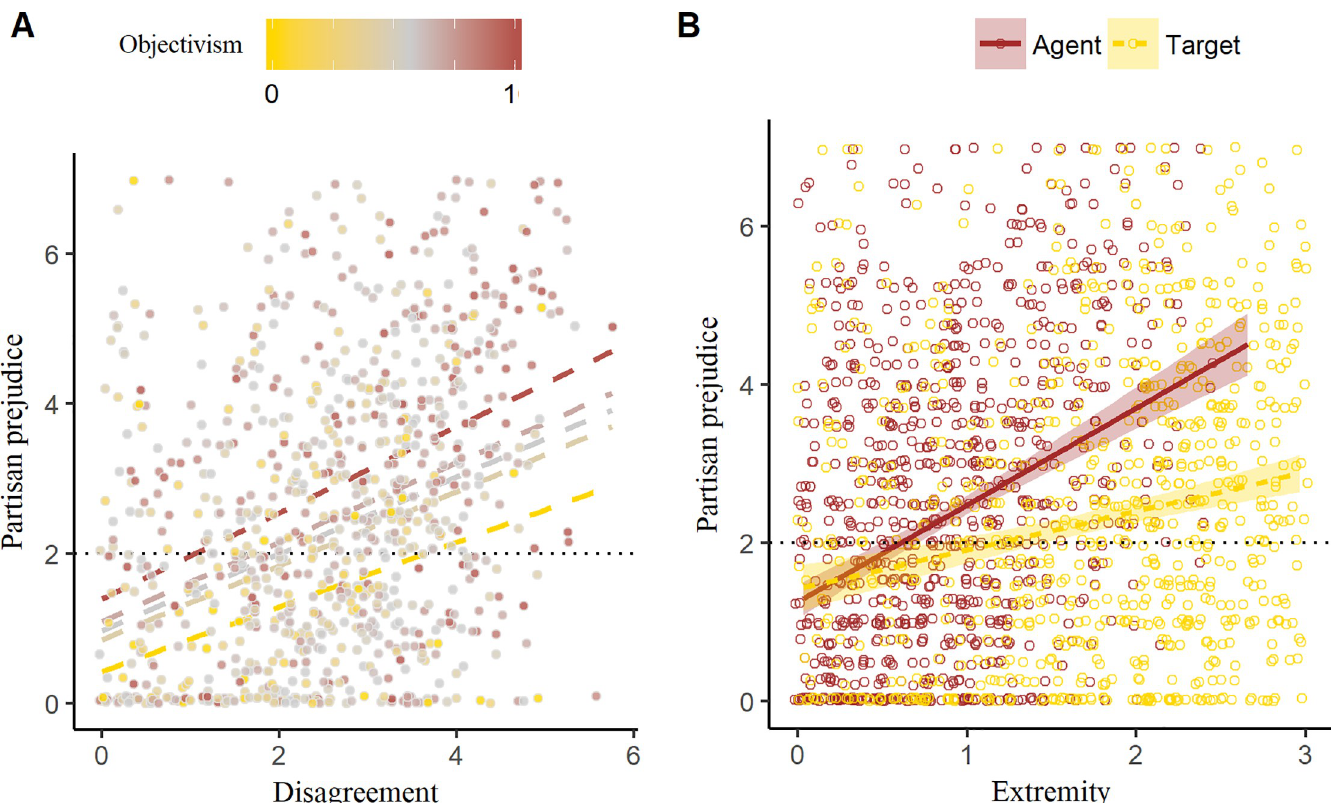
Fig 3. Observed values of partisan prejudice by (A) moral disagreement and (B) extremity. (A) Linear trend lines show the predicted prejudice at different values of meta-ethical belief: Minimum (yellow), Q 1 , Median, Q 3 , and Maximum (brown). The separation between the lines reveals the main effect of meta-ethical belief, while their similar slope attests to the absence of an interaction with disagreement. (B) Linear trend lines show the predicted values of prejudice as a function of agent and target extremity. Both y-axes have been truncated at